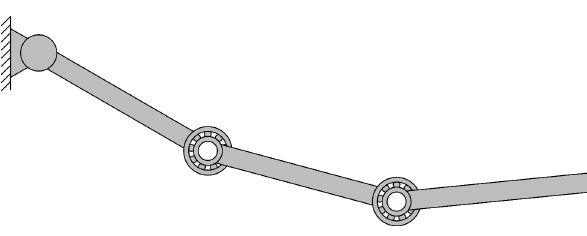
Figure 5: The triple pendulum model with two rolling bearings.